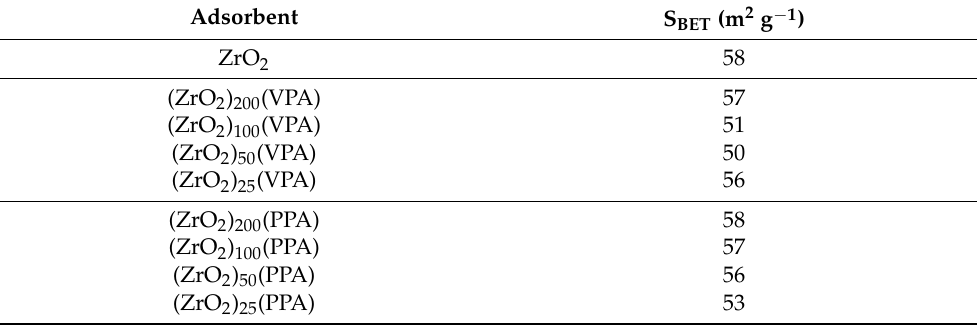
Figure A7. ( a ) Evolution with time of benzo(a)pyrene adsorption using (ZrO 2 ) x (PPA) Samples (Zr/P ratio ( x ) = 50, 100, 200) and ( b ) Pseudo-second-order kinetic plots for the adsorption of benzo(a)pyrene using (ZrO 2 ) x (PPA) Samples (Zr/P ratio ( x ) = 50, 100, 200). Table A1. Textural properties for (ZrO 2 ) x (VPA) and (ZrO 2 ) x (PPA)